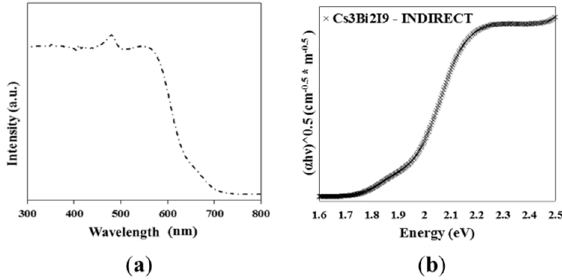
Figure 6. UV–Vis spectrum of Cs 3 Bi 2 I 9 ( a ) and the Kubelka–Munk function for the determination of the bandgap energy of Cs 3 Bi 2 I 9 ( b ).